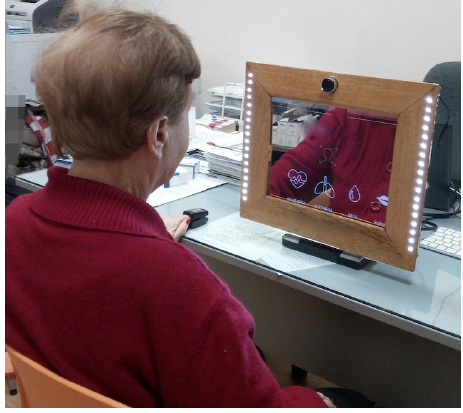
Figure 9. Experimental